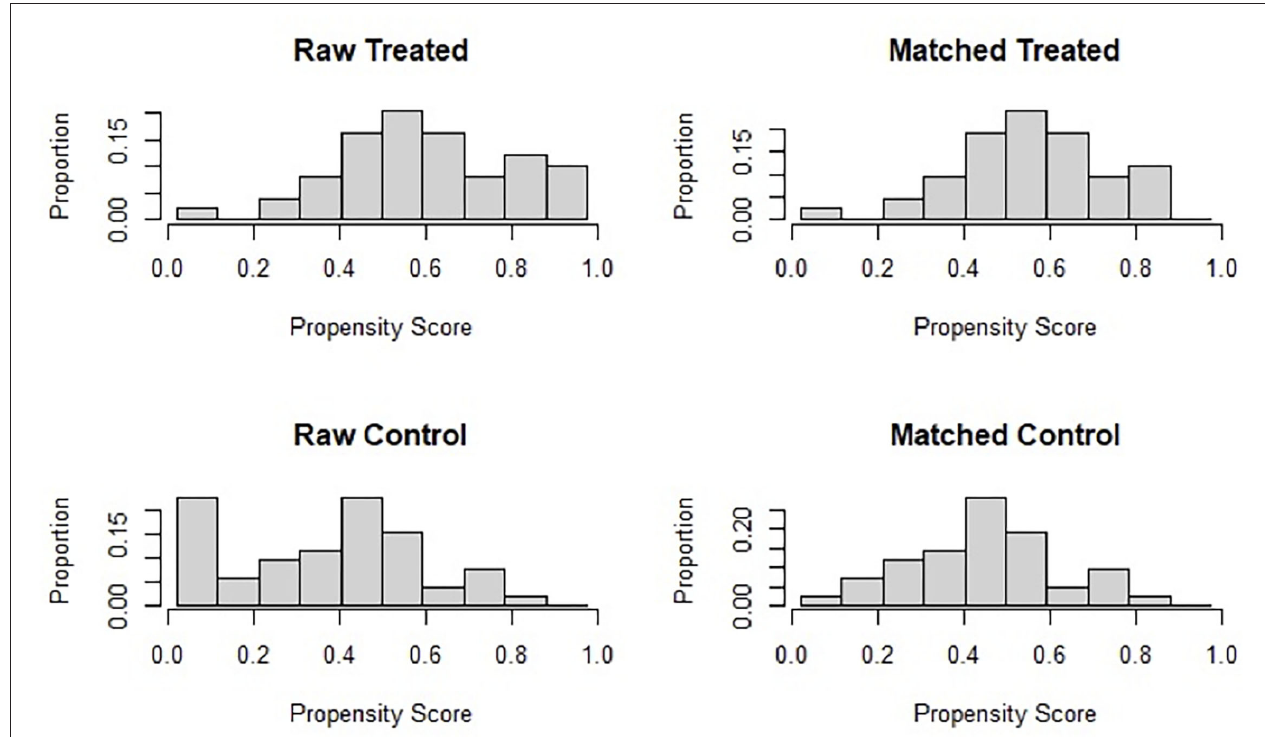
FIGURE 1 | Participants’ flow